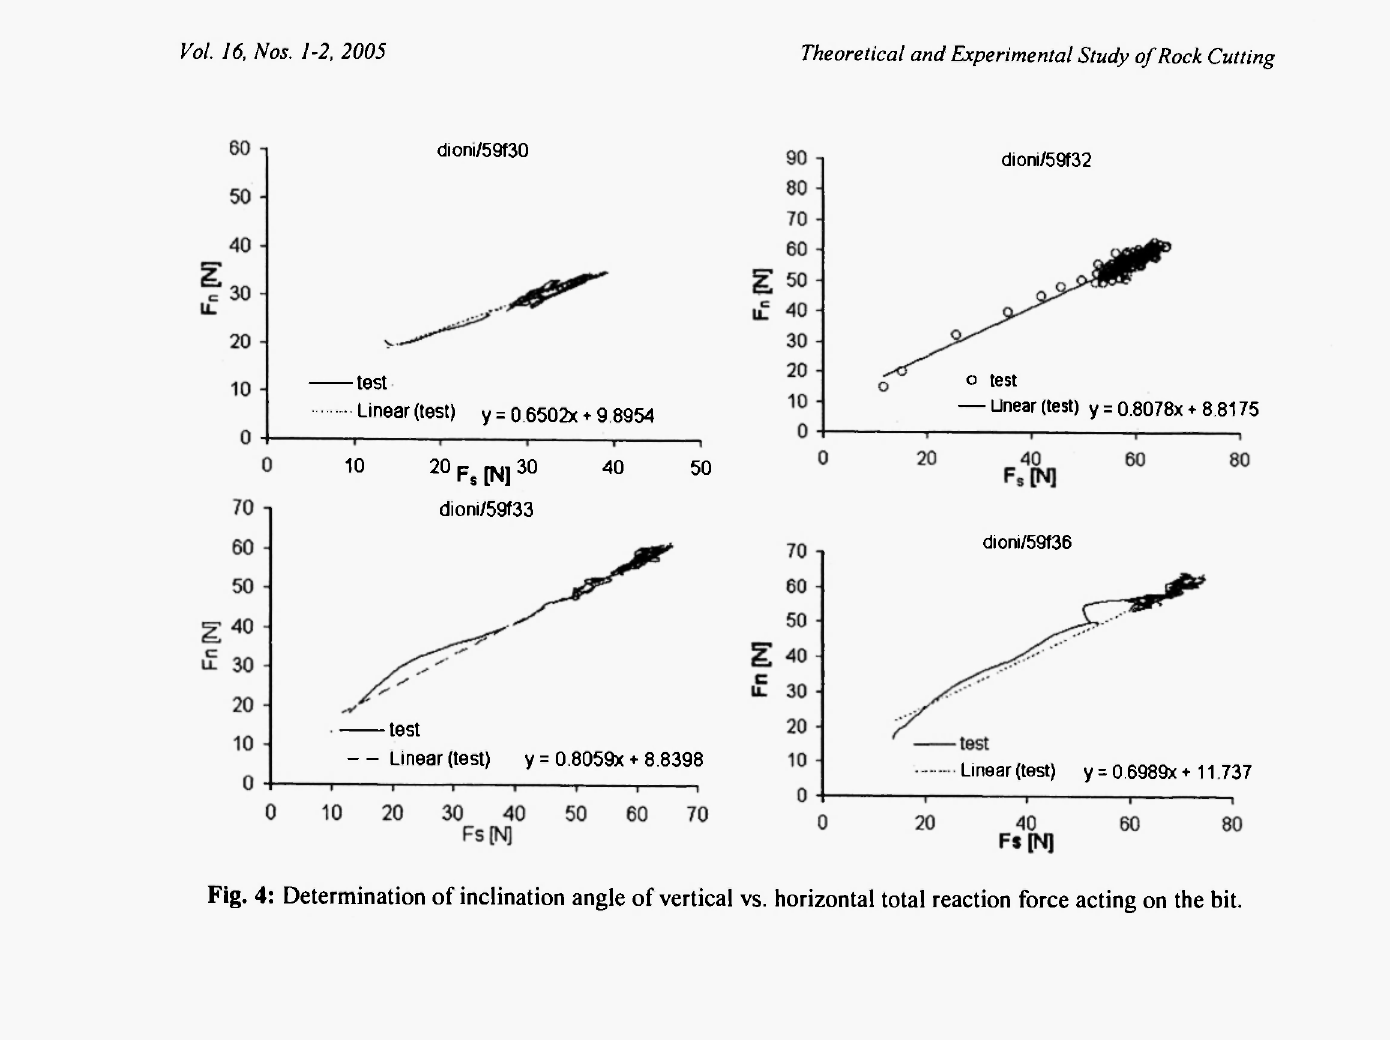
model. The discretization of the numerical model is dense in the region close to the inclined wall in order to capture the localization process (Fig. 5a). The cutting action (tool-rock interaction) is simulated here by prescribing constant horizontal velocity ν to the right of all nodes belonging to the inclined wall (Fig. 5a), whereas the tractions on the horizontal surfaces are prescribed to be zero. The mechanical behaviour of Dionysos marble is approximated by an elastic- perfectly plastic model. For the constitutive law we employ Mohr-Coulomb plasticity, which consists of a yield function f that governs the onset of plastic behaviour f = T + asin(p-ccoscp, and a plastic potential function g which describes the flow rule g = T + osinvy-ccosvj/, where τ is the maximum shear stress, σ is the mean (hydrostatic) stress. The dilation angle ψ is the ratio of the plastic volume change over the plastic shear strain and is positive for volume increase with increasing shearing strain. For Dionysos marble, the cohesion is c=20 MPa, the maximum angle of internal friction is φ = 40°, the dilatancy angle is assumed to be zero , the modulus of elasticity is E=80 GPa and Poisson's ratio ν = 0.33 III. The distorted finite difference grid, as well as contours of maximum shear strain rate corresponding to successive amounts of sliding u along the horizontal plane are illustrated in Fig.